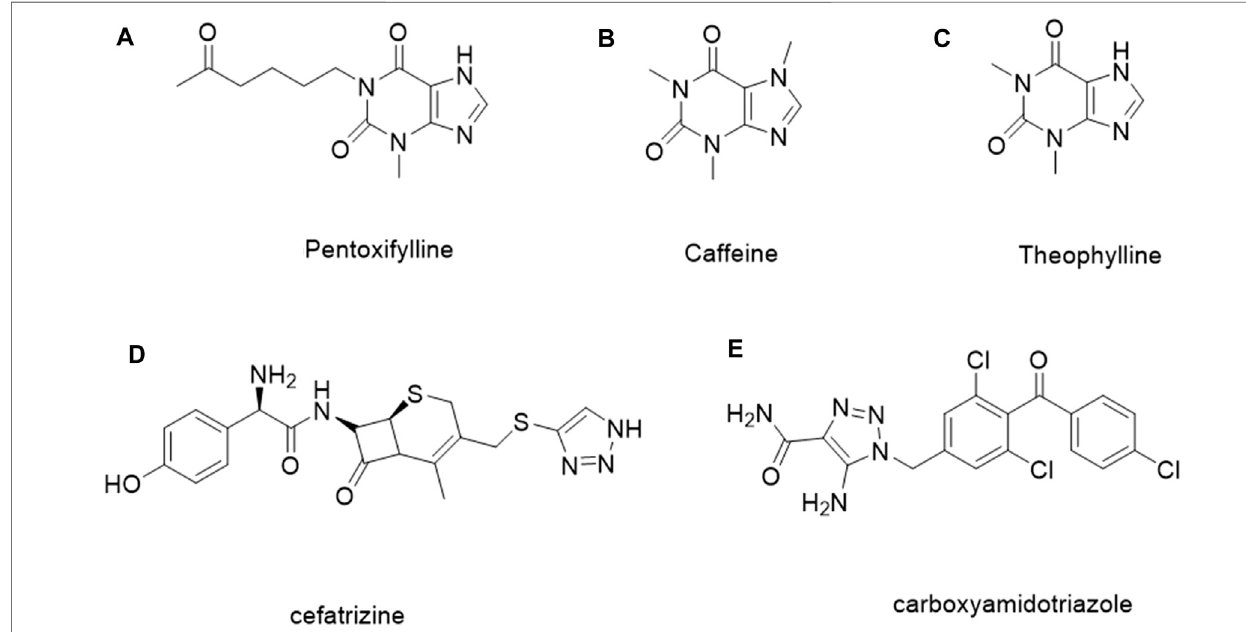
FIGURE 1 | Examples of the methylxanthine-containing compounds and the reported 1, 2, 3-triazole derivatives for treating tumors.